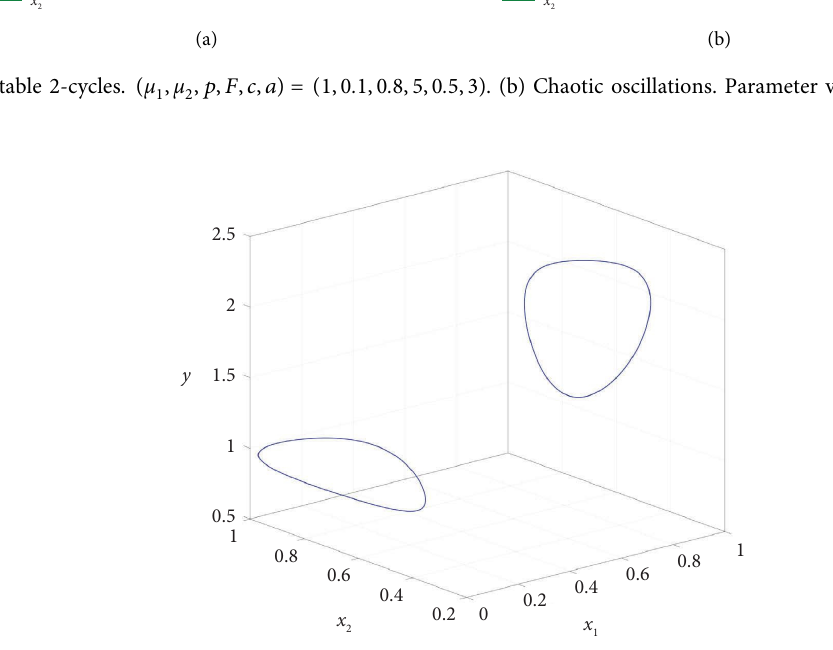
Figure 14: Dynamics generated by map (39). Parameter values ( μ